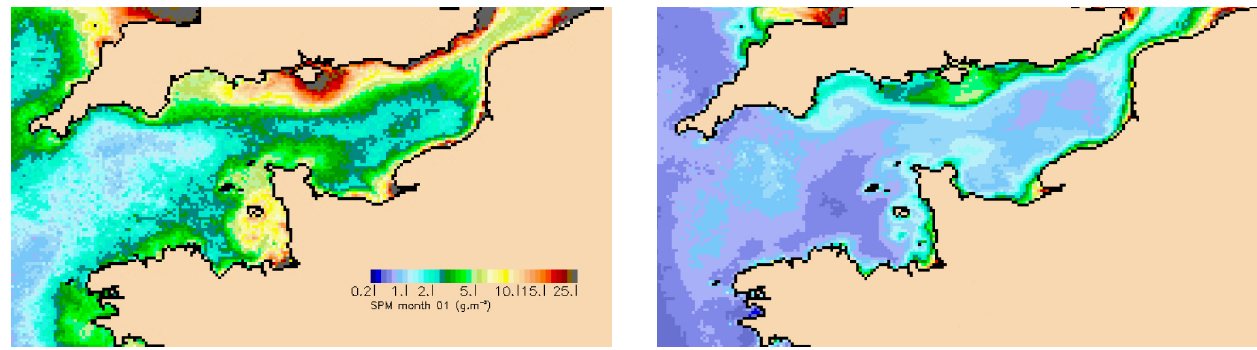
Figure 2. Averaged near-surface suspended sediment concentration (SSC) from MODIS satellite images over the period 2003–2009 for the months of ( left ) January and ( right ) August (Ifremer, Francis